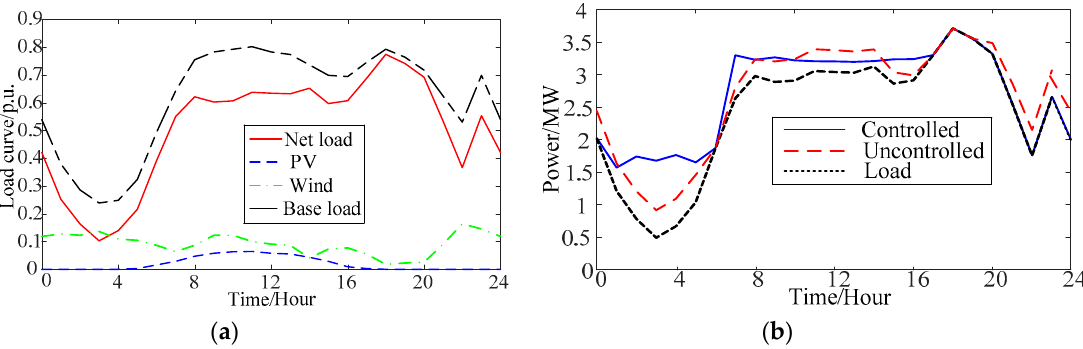
Figure 4. Power load profiles in the distribution network with renewable energy sources: ( a ) Load profiles of 123-bus power network; ( b ) EV charging load with and without control.